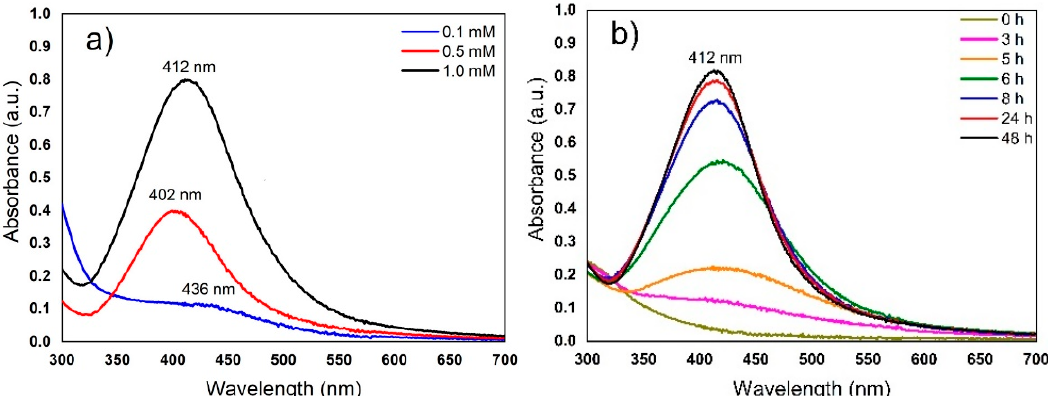
Figure 2. UV–vis spectra of synthesized AgNPs incubated at 25 ± 2 °C under constant shaking at 115 rpm for 24 h. ( a ) Effect of the concentration ratio of AgNO 3 and extract (1:1); ( b ) AgNP synthesis with 1 mM AgNO 3 and extract (1:1) at different time intervals for 48 h.